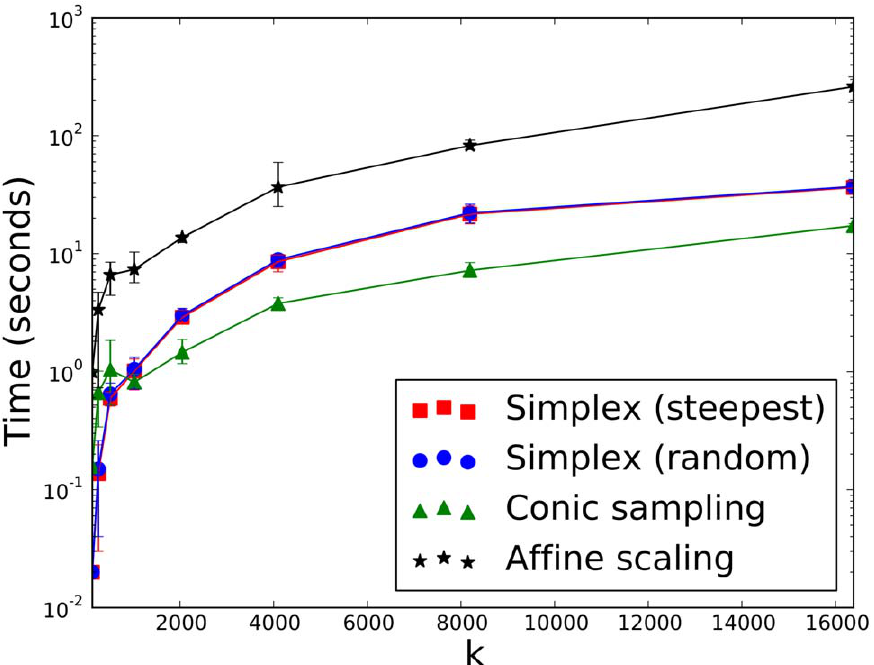
Figure 3. Runtimes on highly sparse, random LPs with varying numbers of constraints. The simplex and affine-scaling algorithms were timed against the conic sampling algorithm on random LP problems with n =100, with 95% sparsity, and with number of constraints k =128,…,16384. For each k , three problems were generated and timed with all algorithms. Error bars indicate minimum and maximum runtimes. Fully sparse vector data structures were used.